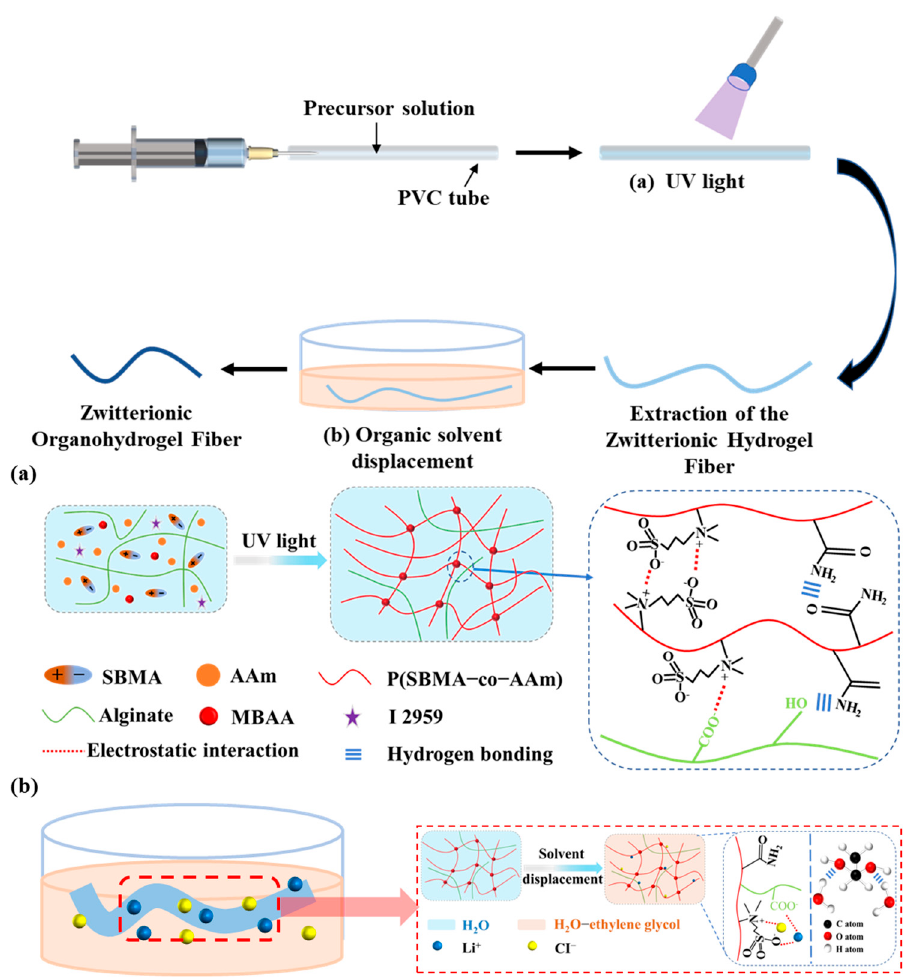
Figure 1. Fabrication strategy of the ZOH fiber. ( a ) Chemical structure of the ZH fiber . ( b ) Schematic of the preparation of the ZOH fiber from the ZH fiber by solvent displacement.